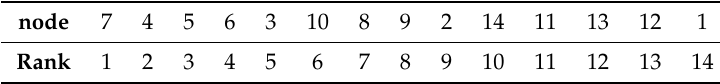
Table 2. Influence ranking of toy network